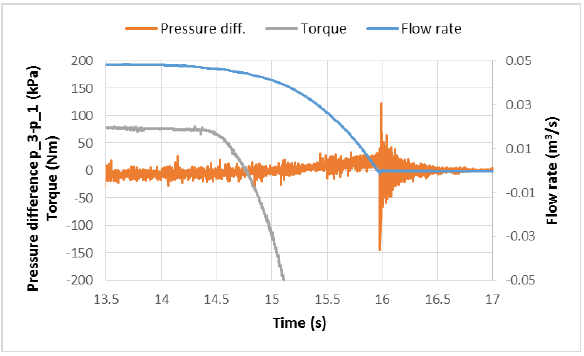
Fig. 10. Pressure difference, torque and calculated flow rate during transition